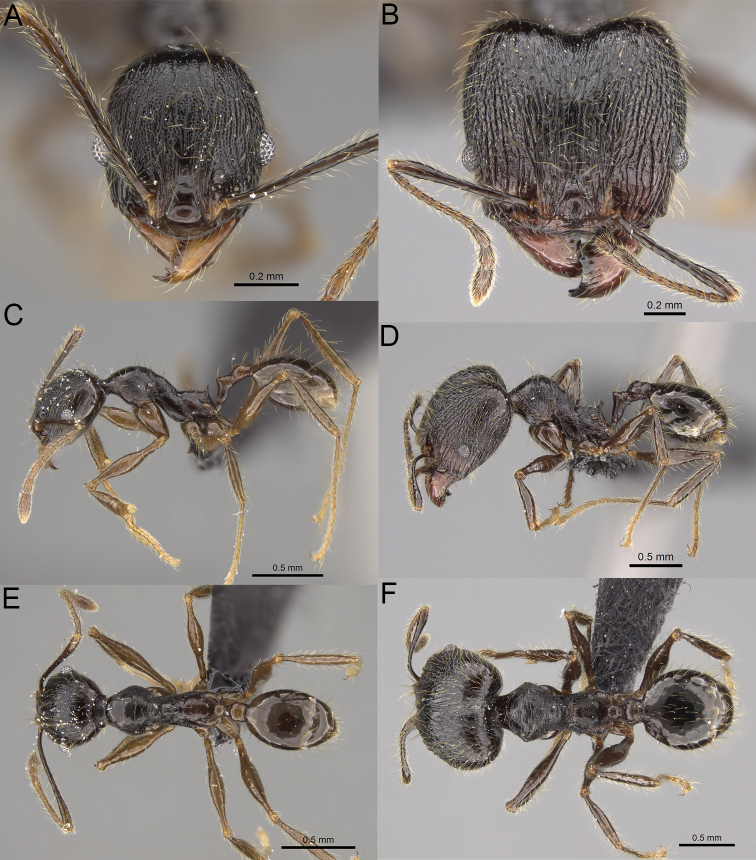
Pheidole
mainty sp. nov., full-face view (A), profile (C), and dorsal view (E) of paratype minor worker (CASENT0809553) and full-face view (B), profile (D), and dorsal view (F) of holotype major worker (CASENT0923261).